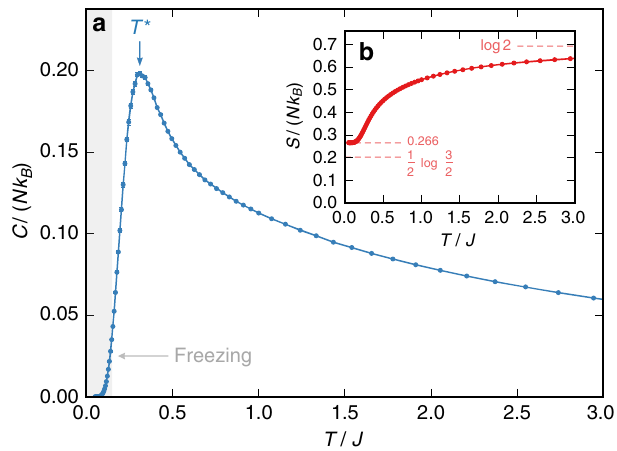
Figure 3 | Specific heat and entropy of extended spin ice. Finite temperature ( a ) specific heat, C , and ( b ) entropy, S , of the spin slush model for a system of 10 3 conventional cubic cells of the pyrochlore lattice. Entrance into the spin slush manifold is signalled by the peak in the specific heat at T * B 0.3 J . Residual entropy as T - 0 is S B 0.266 Nk B . Freezing becomes apparent below T B 0.15 J , as indicated by the shaded region.